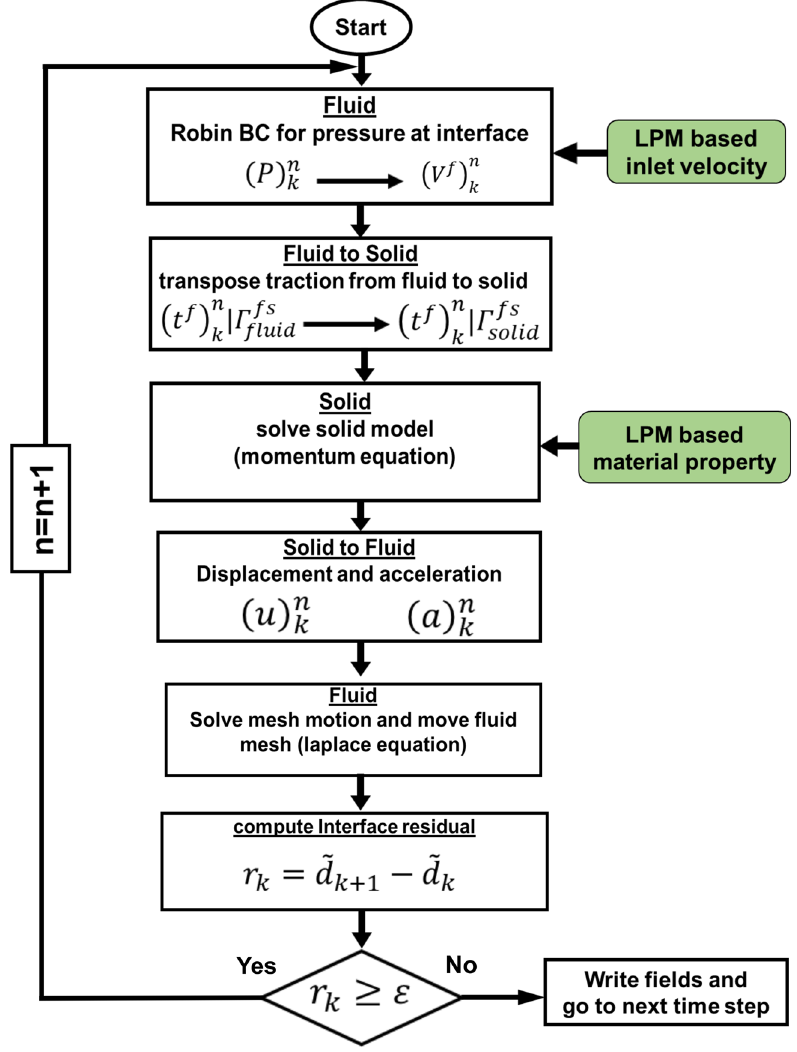
Figure 2. LPM and strongly coupled FSI algorithm flow